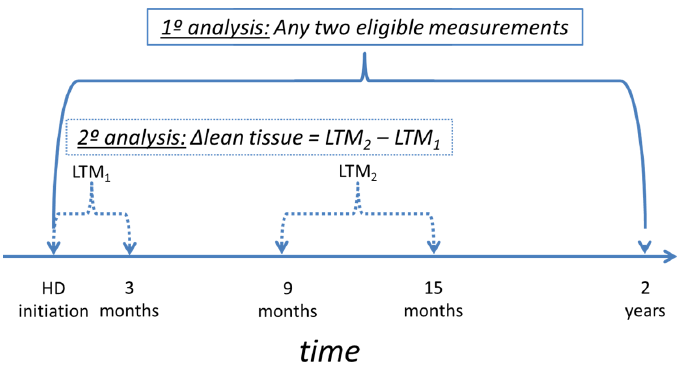
Figure 1. Timeline of data included in primary and secondary analyses. Primary analysis defining body composition changes used data from any patient with more than one Body Composition Monitor (BCM) measurement in the first 2 years of haemodialysis (HD). For secondary analysis of survival, data for calculating the change in lean tissue over the first year of HD, ∆ lean tissue came from discrete periods. LTM 1 is the lean tissue mass from the first BCM measurement in the period 0–3 months. LTM 2 is the lean tissue mass for the BCM measurement closest to the anniversary of HD initiation, within the 9–15 months window.